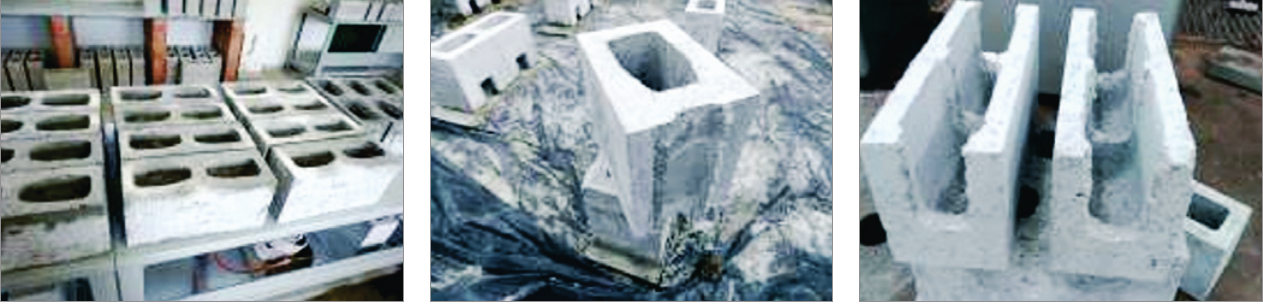
2.4 Construção dos prismas e paredes